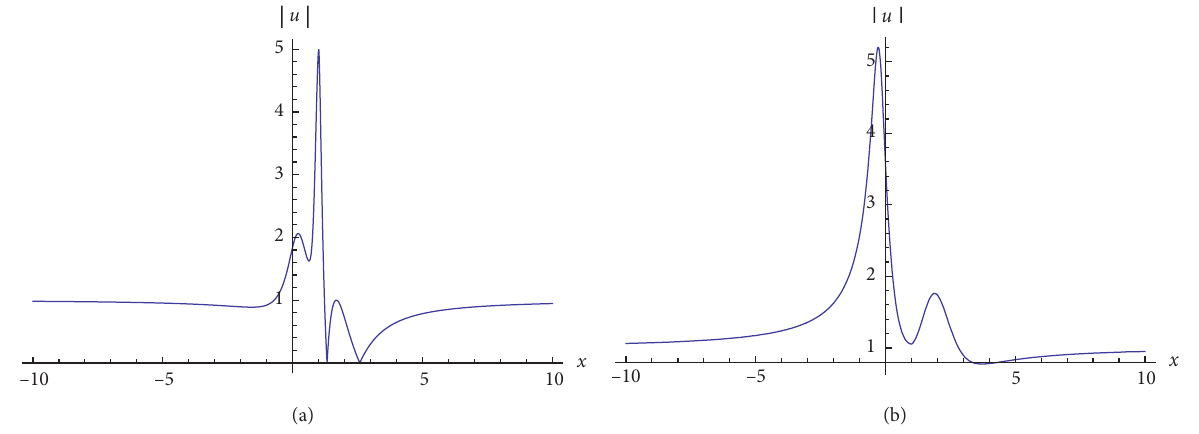
Figure 17: Amplitudes of the symmetric second-order fractional rogue wave with α � 5/6 and a � 1 modified from solution (39). (a) t � 1. (b) t � 2.